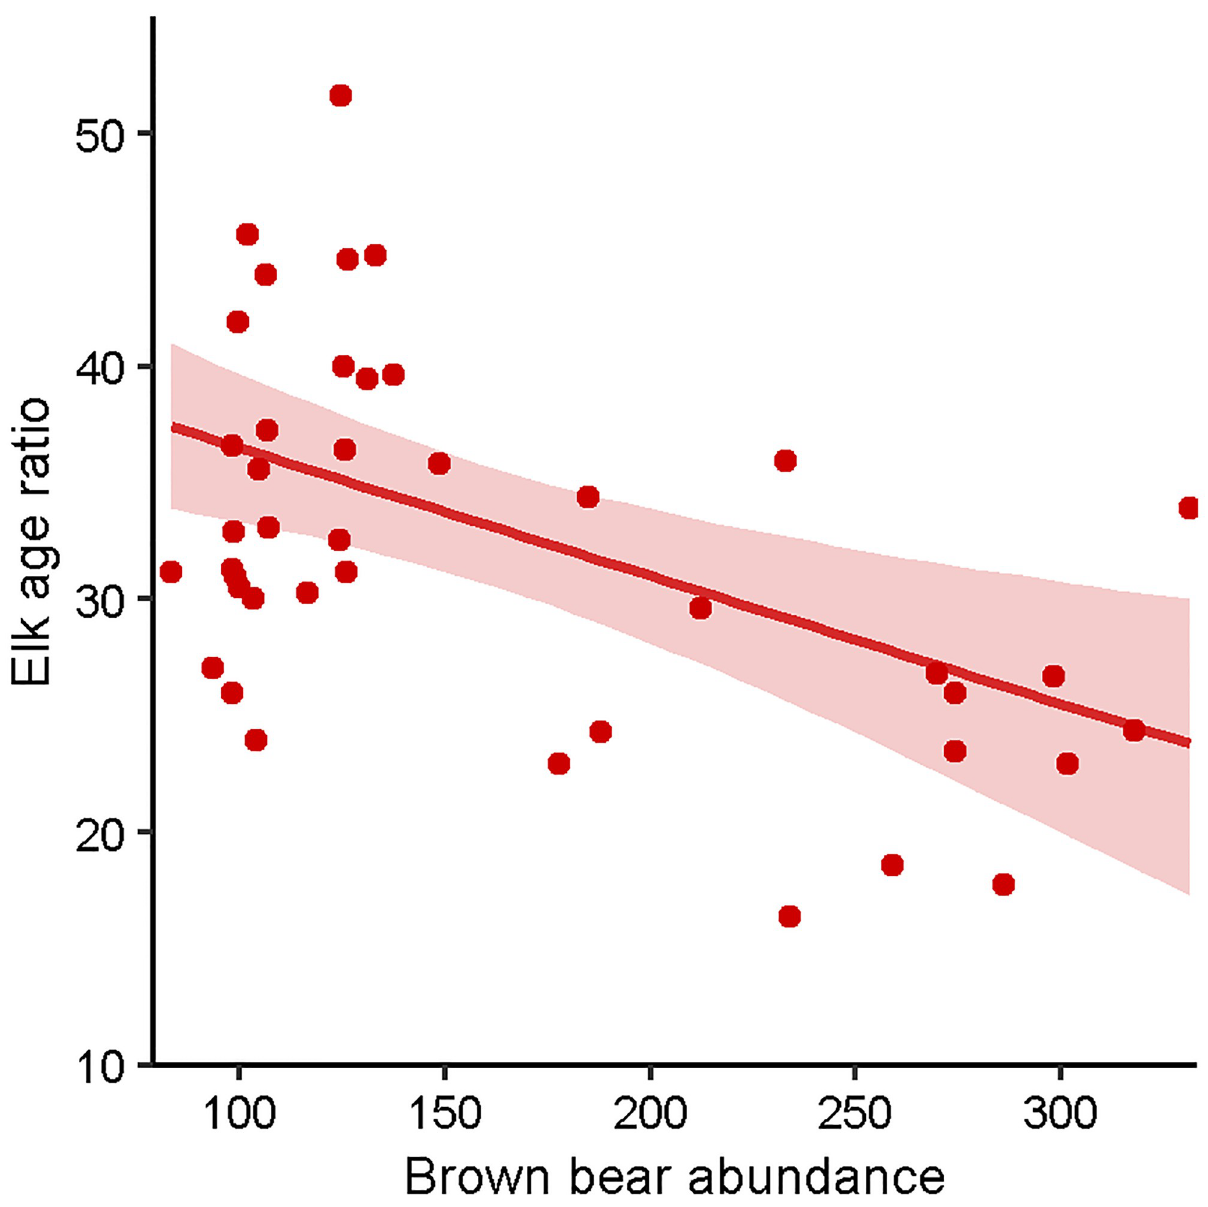
Fig 3. Elk age ratios predicted by brown bear abundance by the non-timber harvest recruitment model. Model-predicted response of semi-annual elk age ratios (calves per 100 adult females) in non-timber harvest area as a function of brown bear abundance with 95% credible interval (shading), Afognak and Raspberry islands, Alaska, USA,